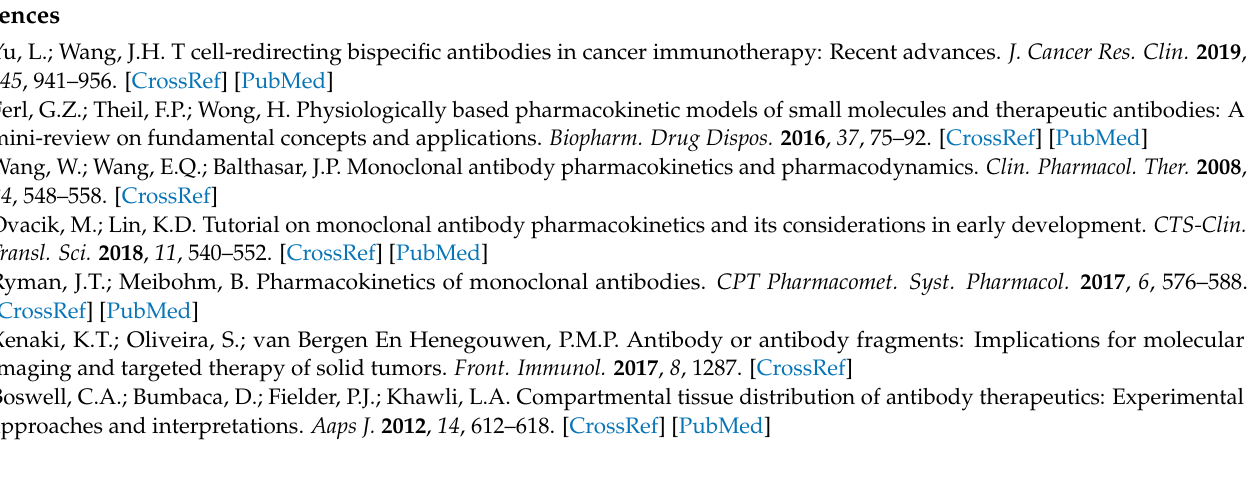
Figure S1: Quality control to ensure retention of the biological activity after labelling of the TCBs with 125 Iodine. Figure S2: PBPK model simulations before and after adaptions. Supplementary material S2: Simbiology PBPK model equations and definitions. Supplementary Table S2: Parameter